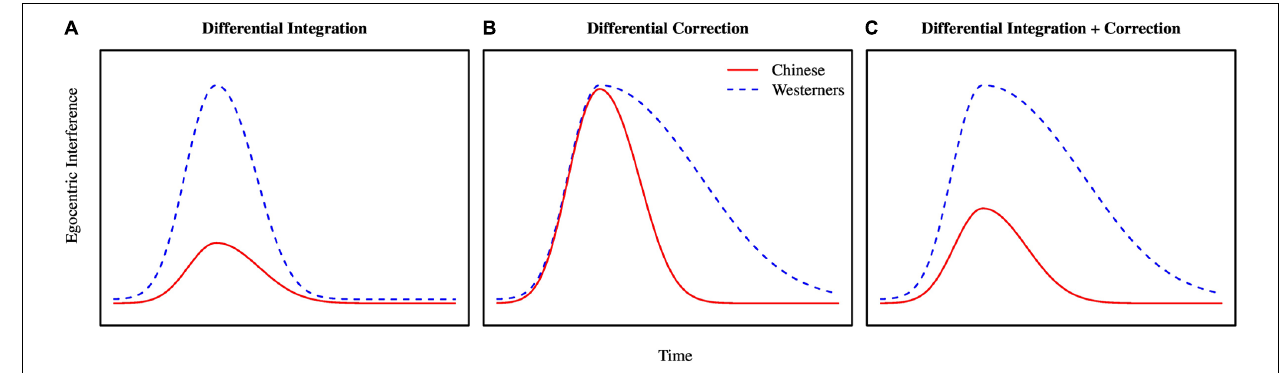
FIGURE 1 | Predictions of differential integration (A), differential correction (B), and differential integration plus correction (C).